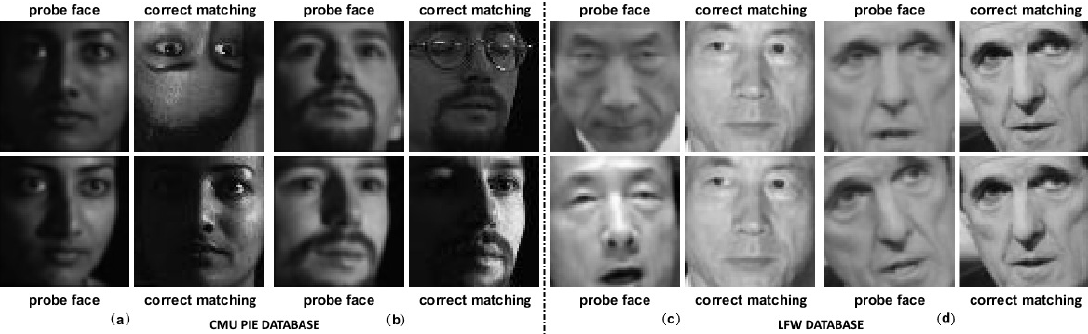
Figure 4. LBP histograms comparison.